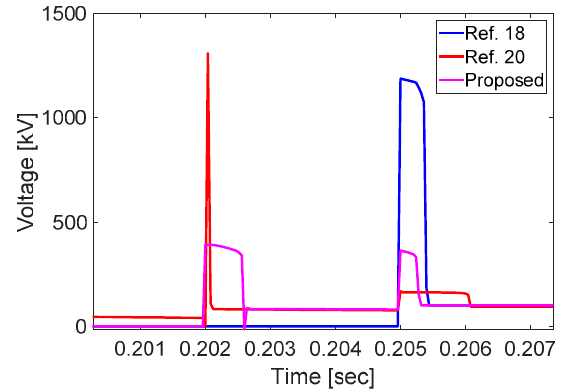
Figure 17. Voltage across the breaker under influence of different solutions.